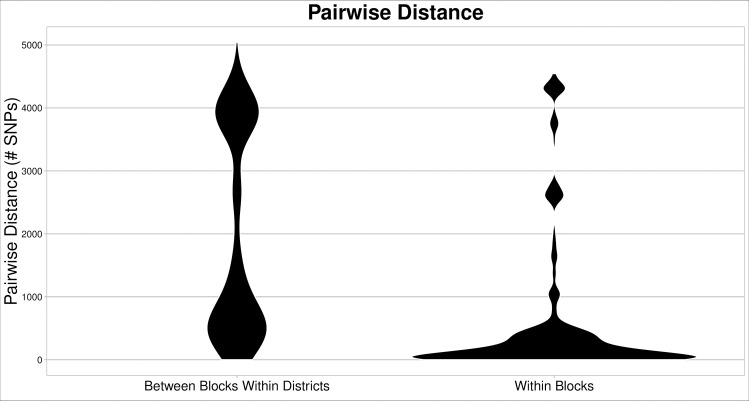
T. cruzi isolates collected from the same block are genetically similar.Violin plots represent the number of pairwise SNP differences among pairs of samples collected in different blocks from the same district (left) and among pairs of samples collected in the same block (right). The width of the violins represents the frequency that pairwise distances were detected. Samples found in different blocks within a district are significantly more different from one another than samples collected within the same city block (p<0.001). Genetically-similar samples tend to cluster within blocks despite each district containing much of the overall genetic diversity among all samples.